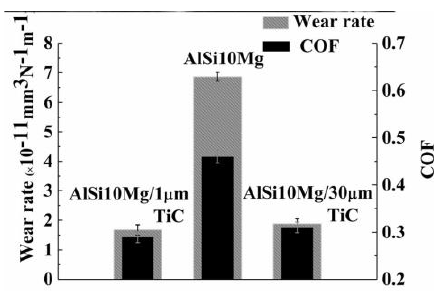
Figure 17. Wear rate and coefficient of friction (COF) for the SLM-processed non-reinforced AlSi10Mg as well as 15 wt.%TiC/AlSi10Mg composite systems with two different TiC particle size [53].